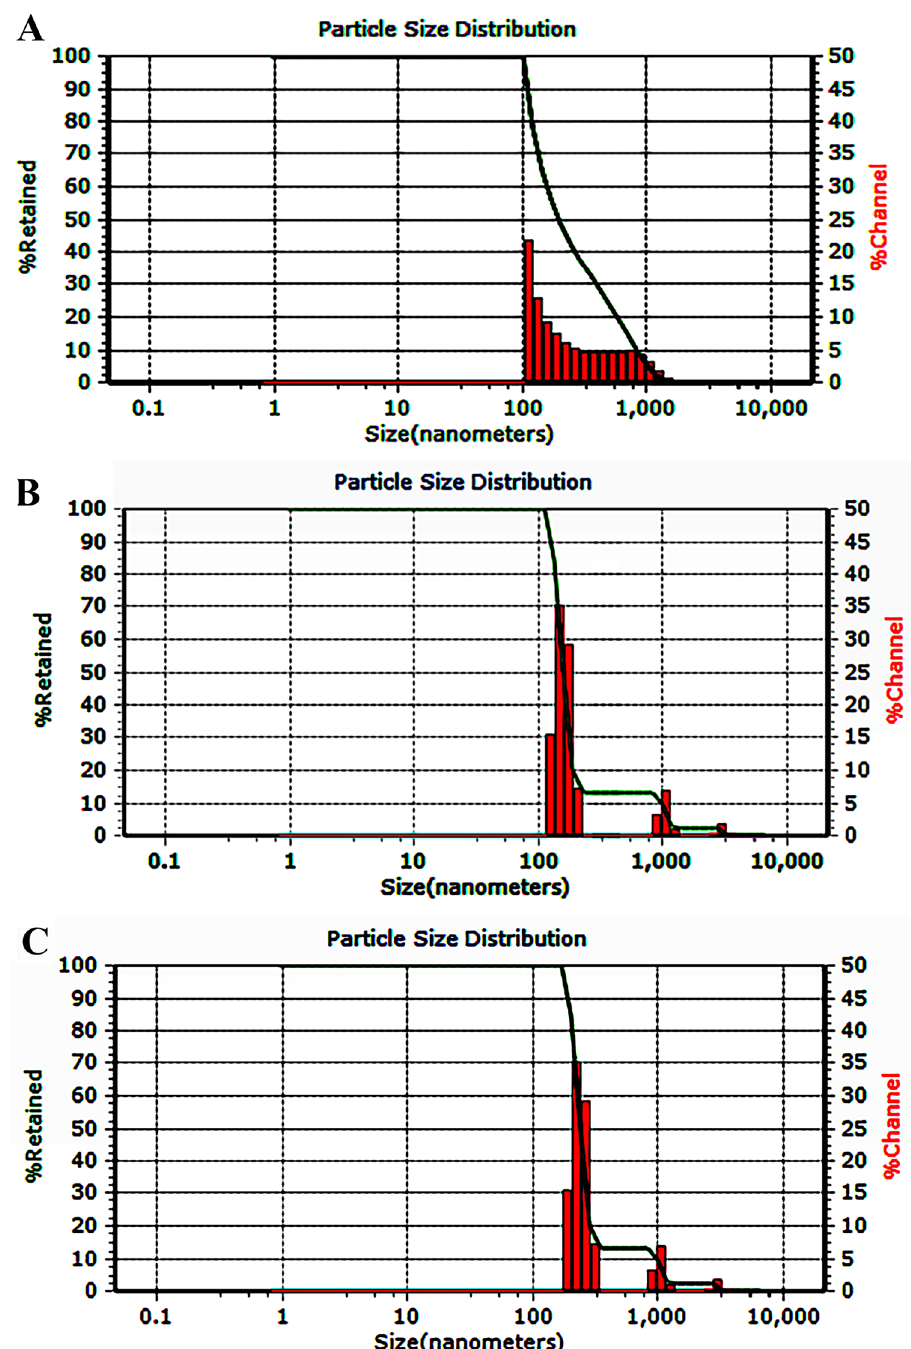
Figure 4. DLS patterns of ( A ) Mlt; ( B ) ZnO/Mlt-NC; and ( C )